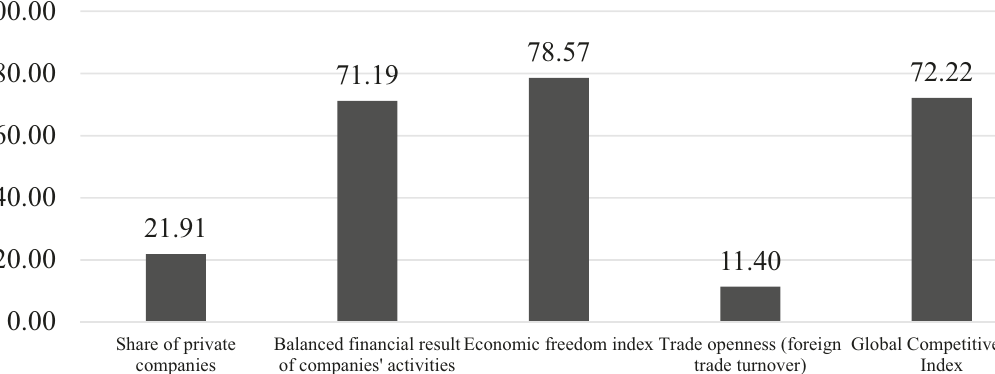
Fig. 3 Correlation between ‘ capitalism 4.0 ’ in Russia and the share of the population without information security problems (%). Source: Calculated by the